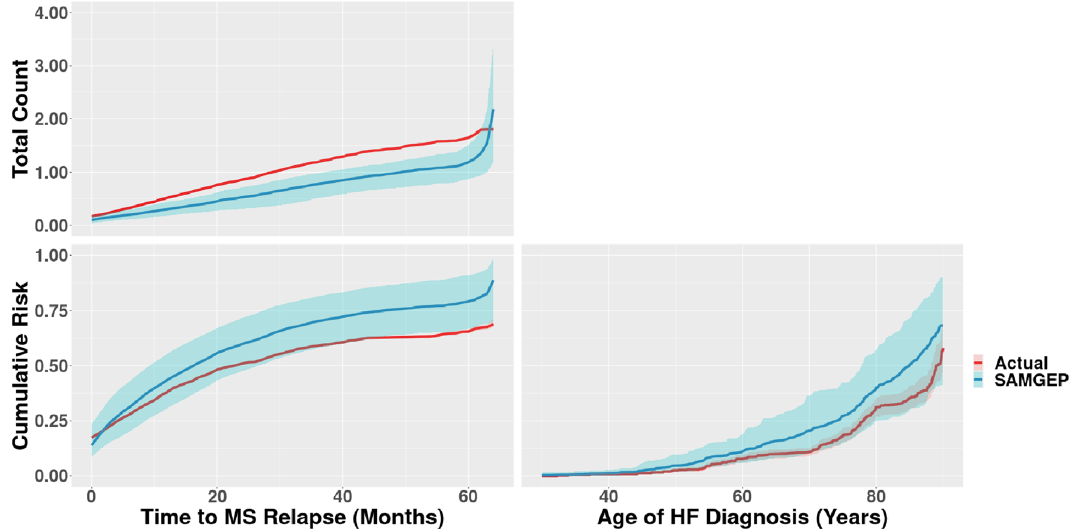
Figure 5. Estimation of population-wide cumulative probability (bottom) and counting process (top) curves for MS relapse (left) and HF development (right) using the predictions of SAMGEP trained with n = 100 labeled patients. “Actual” curves were estimated using all available labels. Only labeled sets were used to generate curve estimates in order to enable unbiased comparison between the SAMGEP-predicted and actual curves. 95% confidence intervals were empirically estimated by bootstrapping with 100 replicates. More extensive results are displayed in Supplementary Fig.